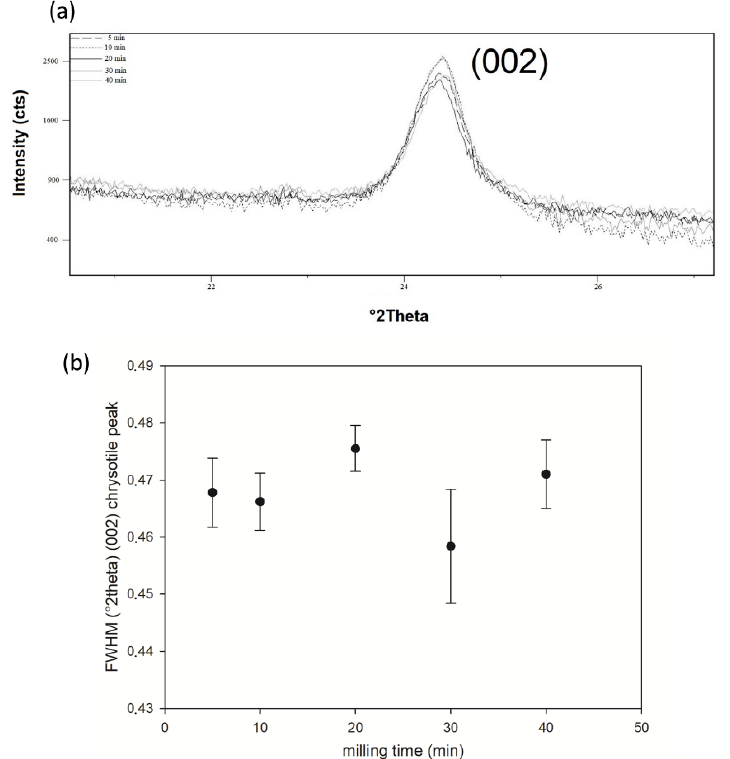
Figure 4. ( a ) X-ray diffraction pattern of cryo-milled chrysotile in the ◦ 2Theta range from 21 to 27. The image shows the negligible effect of milling on the chrysotile (002) peak. ( b ) Variation of Full Width at Half-Maximum (FWHM) of (002) chrysotile peak with time of